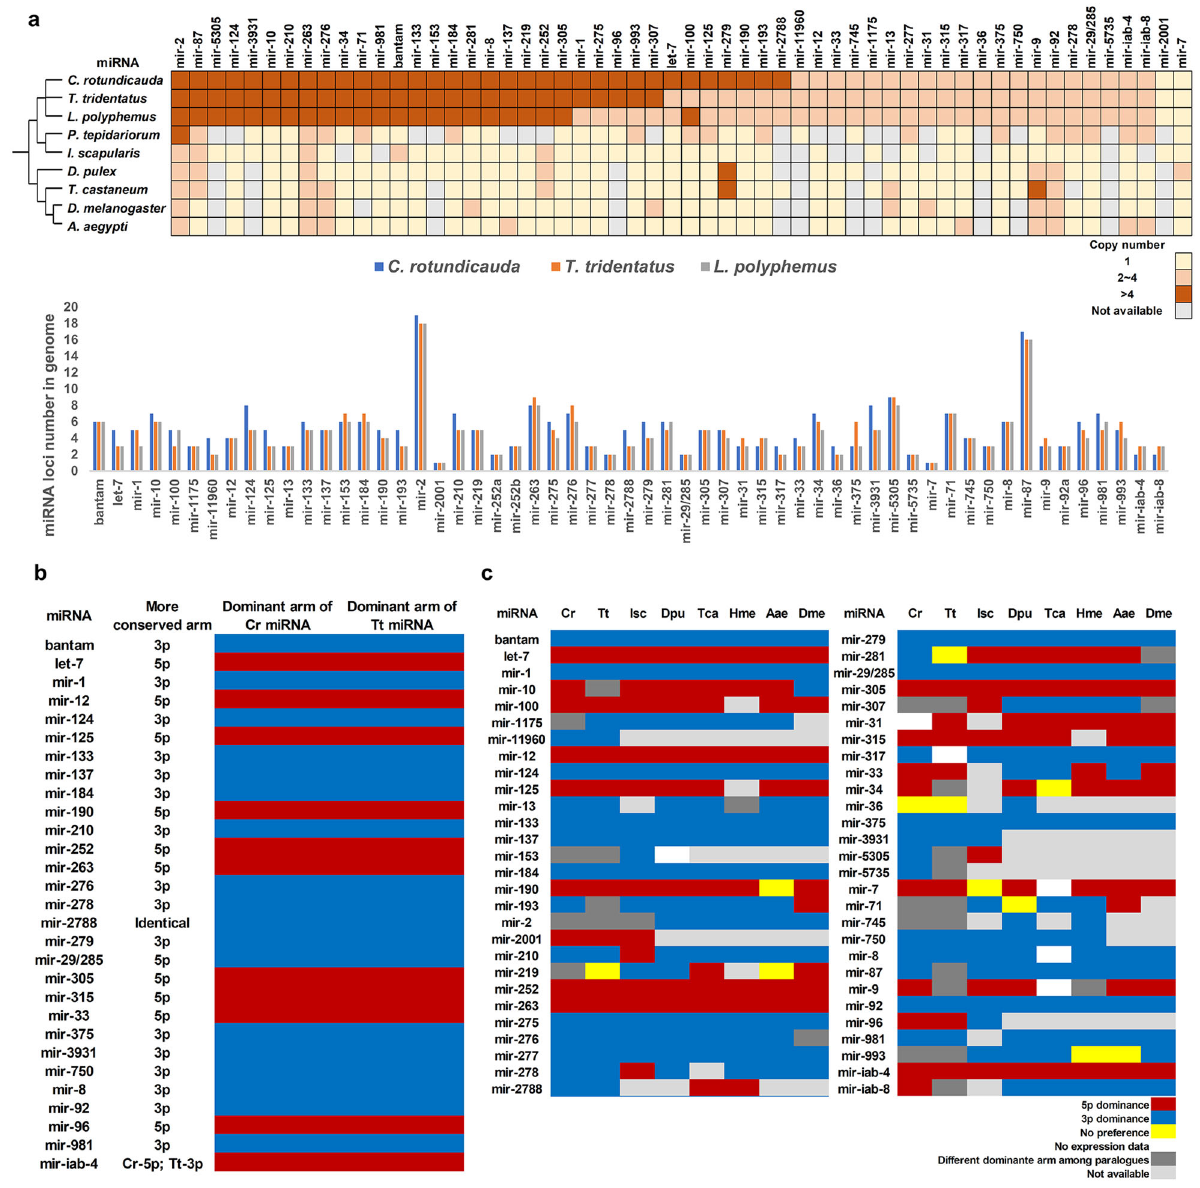
Fig. 4 MicroRNA copies and dominant arm usage. a Number of gene copies of conserved microRNAs in the arthropod genomes; b Sequence conservation and arm switching of horseshoe crab microRNAs; c Comparison of microRNA arm preference among different arthropod species. Isc Ixodes scapularis , Dpu Daphnia pulex , Tca Tribolium castaneum , Hme Heliconius melpomene , Aae Aedes aegypti , Dme Drosophila melanogaster . Arm preference: blue — 3p dominance, red — 5p dominance, yellow — no preference, white — no expression. Source data reveals Fig. 4a can be found in Supplementary Data